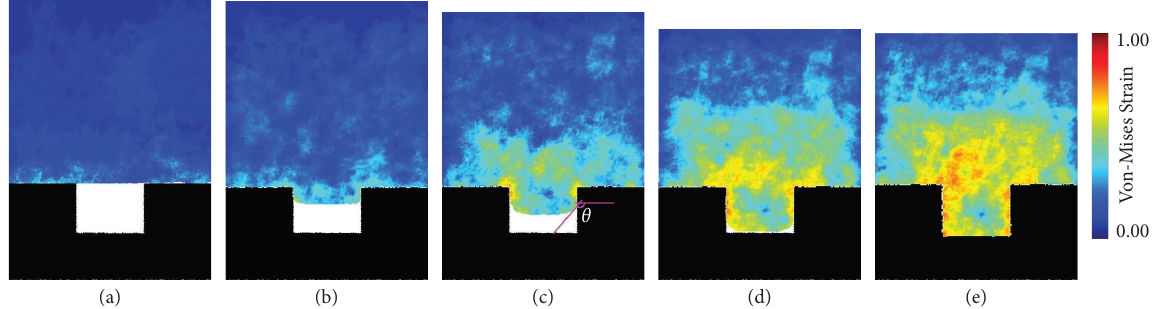
Figure 6: Evolution of imprinting process with groove pattern at 300K for mold displacement of (a) 0 nm, (b) 1.1nm, (c) 2.9nm, (d) 3.5nm, and (e) 4.38